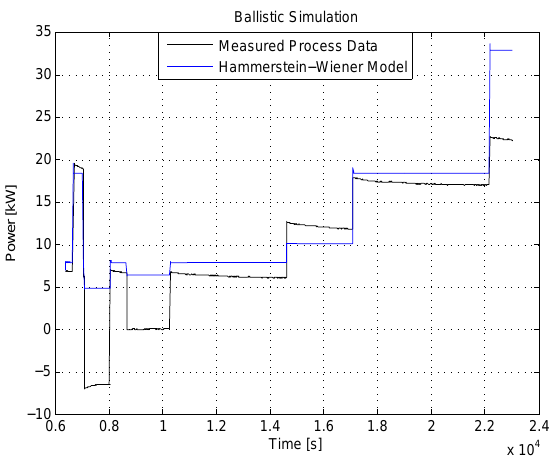
Figure 11: Ballistic simulation using the Hammerstein- Wiener model, which was identified using the default f ( u ), h ( x ), n b , and n f of the GUI in the MATLAB System Identification